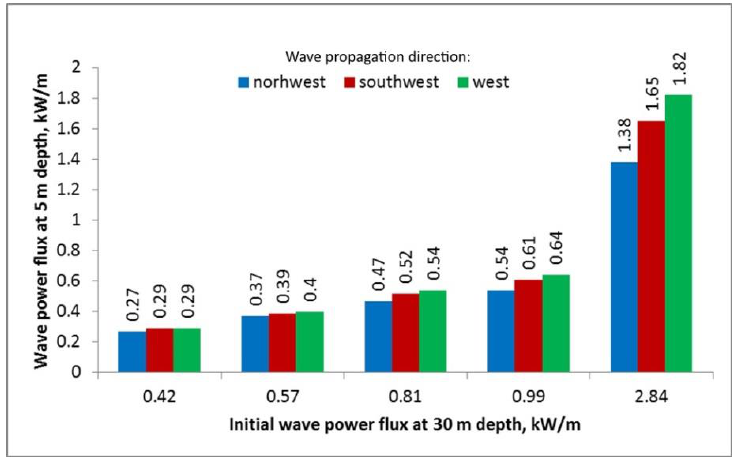
Figure 5. The change in power flux of waves propagating to the shore.